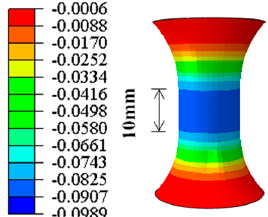
Figure 2. Strain distribution along the gauge length under high compressive strain ( ε = − 10%).